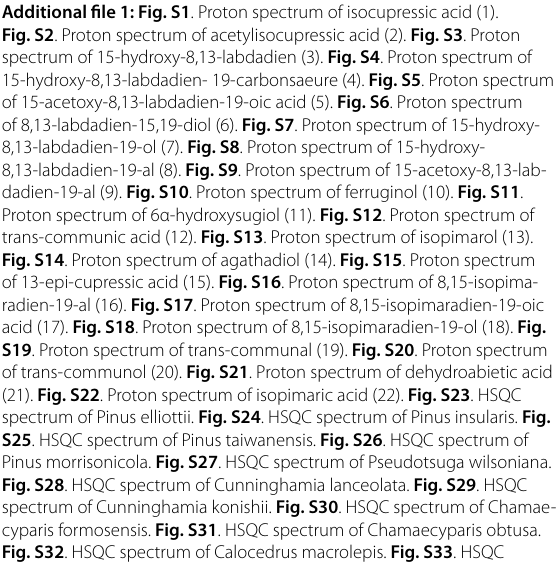
Pinus morrisonicola. Fig. S27 . HSQC spectrum of Pseudotsuga wilsoniana. Fig. S28 . HSQC spectrum of Cunninghamia lanceolata. Fig. S29 . HSQC Fig. S32 . HSQC spectrum of Calocedrus macrolepis. Fig. S33 . HSQC